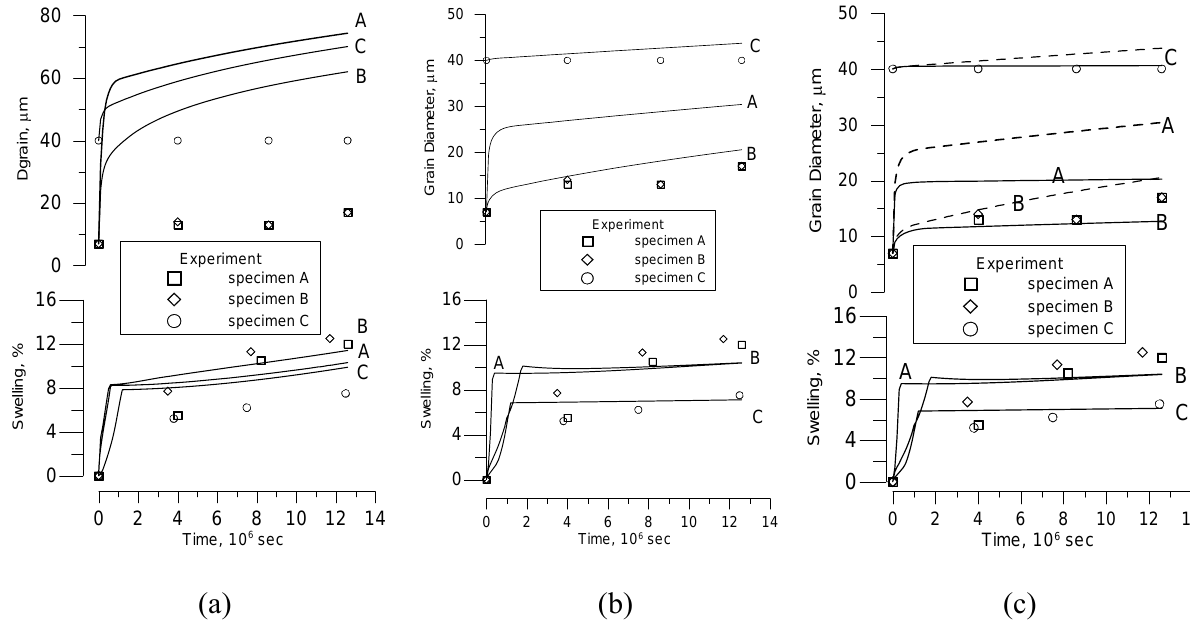
Figure 7. MFPR simulation of grain size in Turnbull’s test. (a) Standard migration mechanism. (b) Grain boundary diffusion mechanism applied to grain face bubbles. (c) Grain boundary diffusion mechanism applied to all grain boundary bubbles ( solid lines ) in comparison with case (b) ( dashed lines